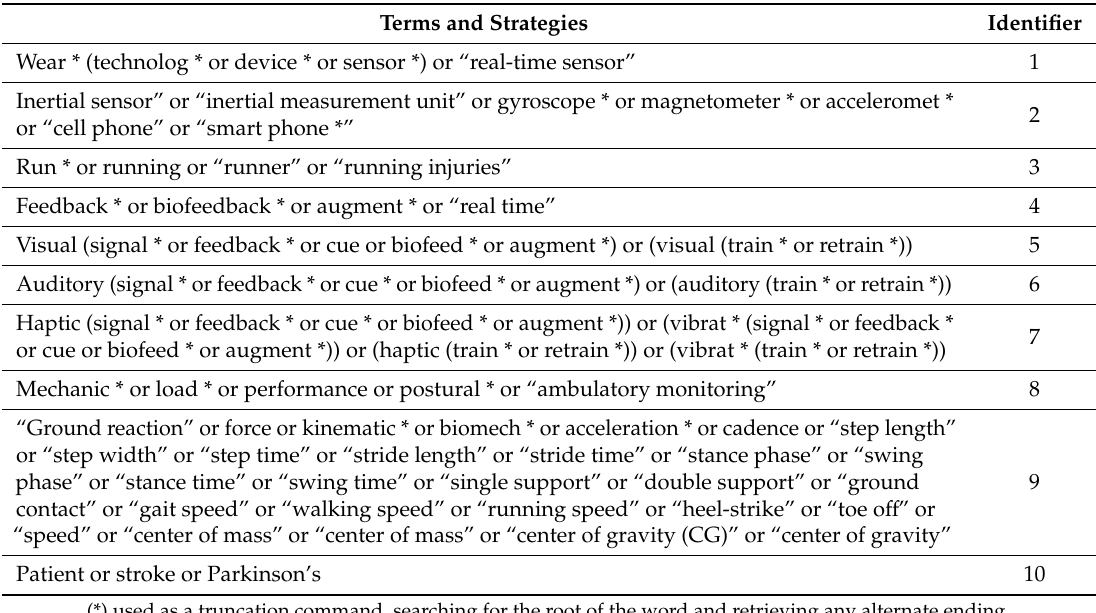
Table 1. Keywords and subject headings descriptors grouped by